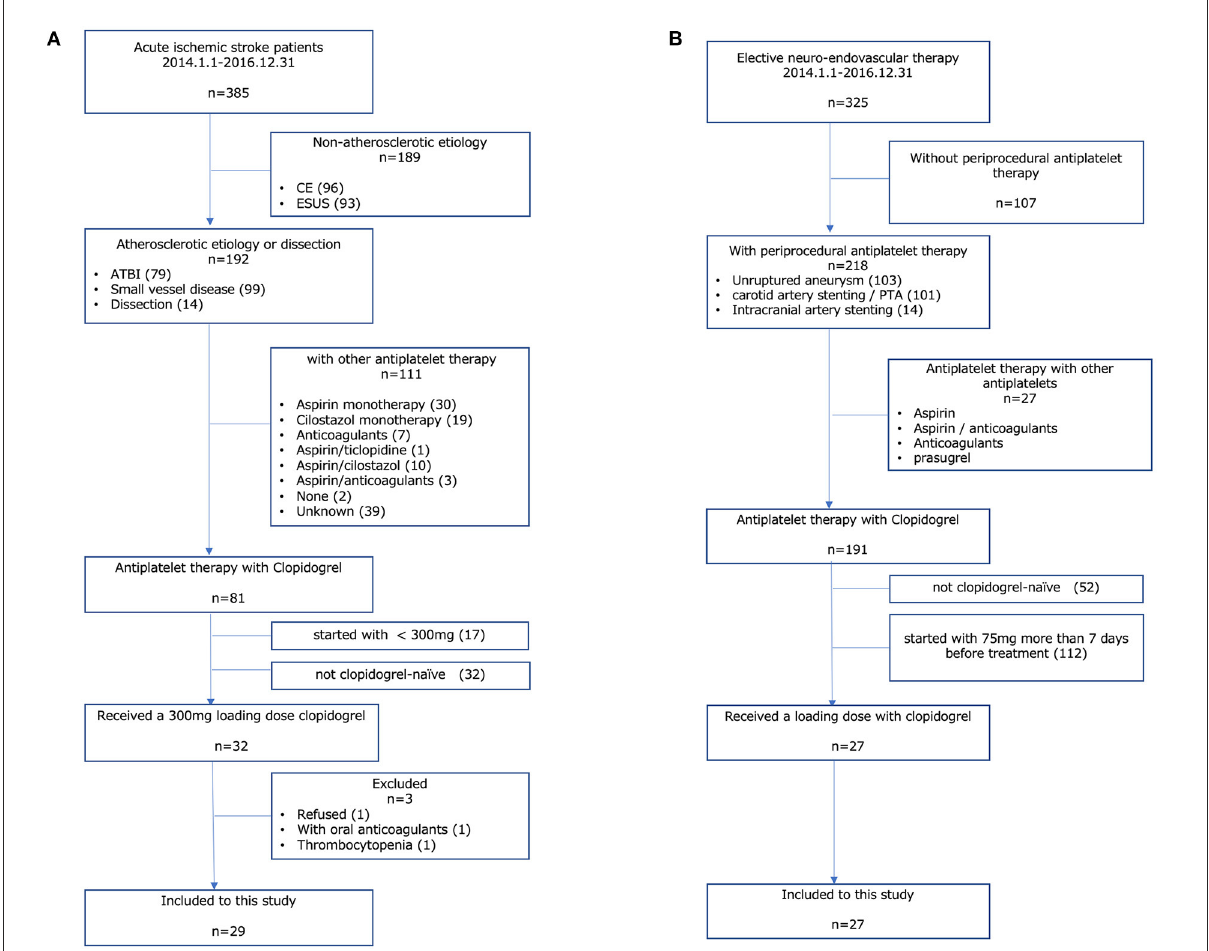
FIGURE1 Study population. (A) AIS group, (B) other CVD group. AIS, acute ischemic stroke; CVD, cerebrovascular disease; CE, cardiac embolism; ESUS, embolic stroke from undetermined sources; ATBI, atherothrombotic brain infarction.